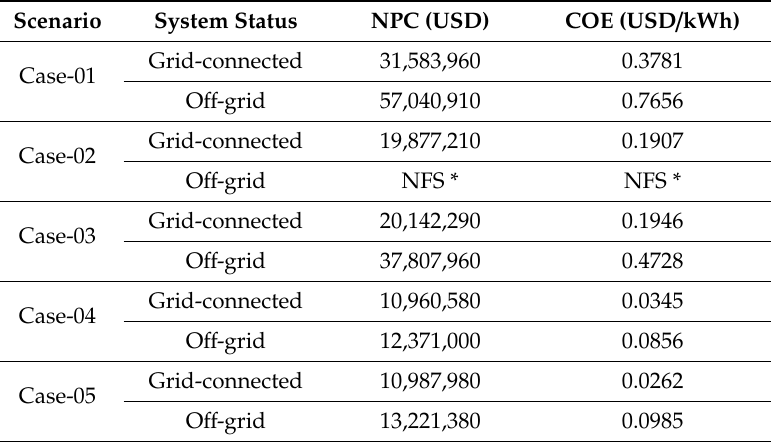
Table 17. Case-wise comparison of NPC and